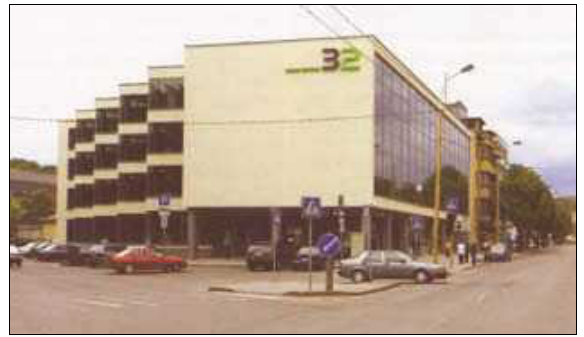
(ar­chit. G. natkevičiu­s ir­ kt.) Fig. 4. “Vilniau­s bankas“ bu­ilding in